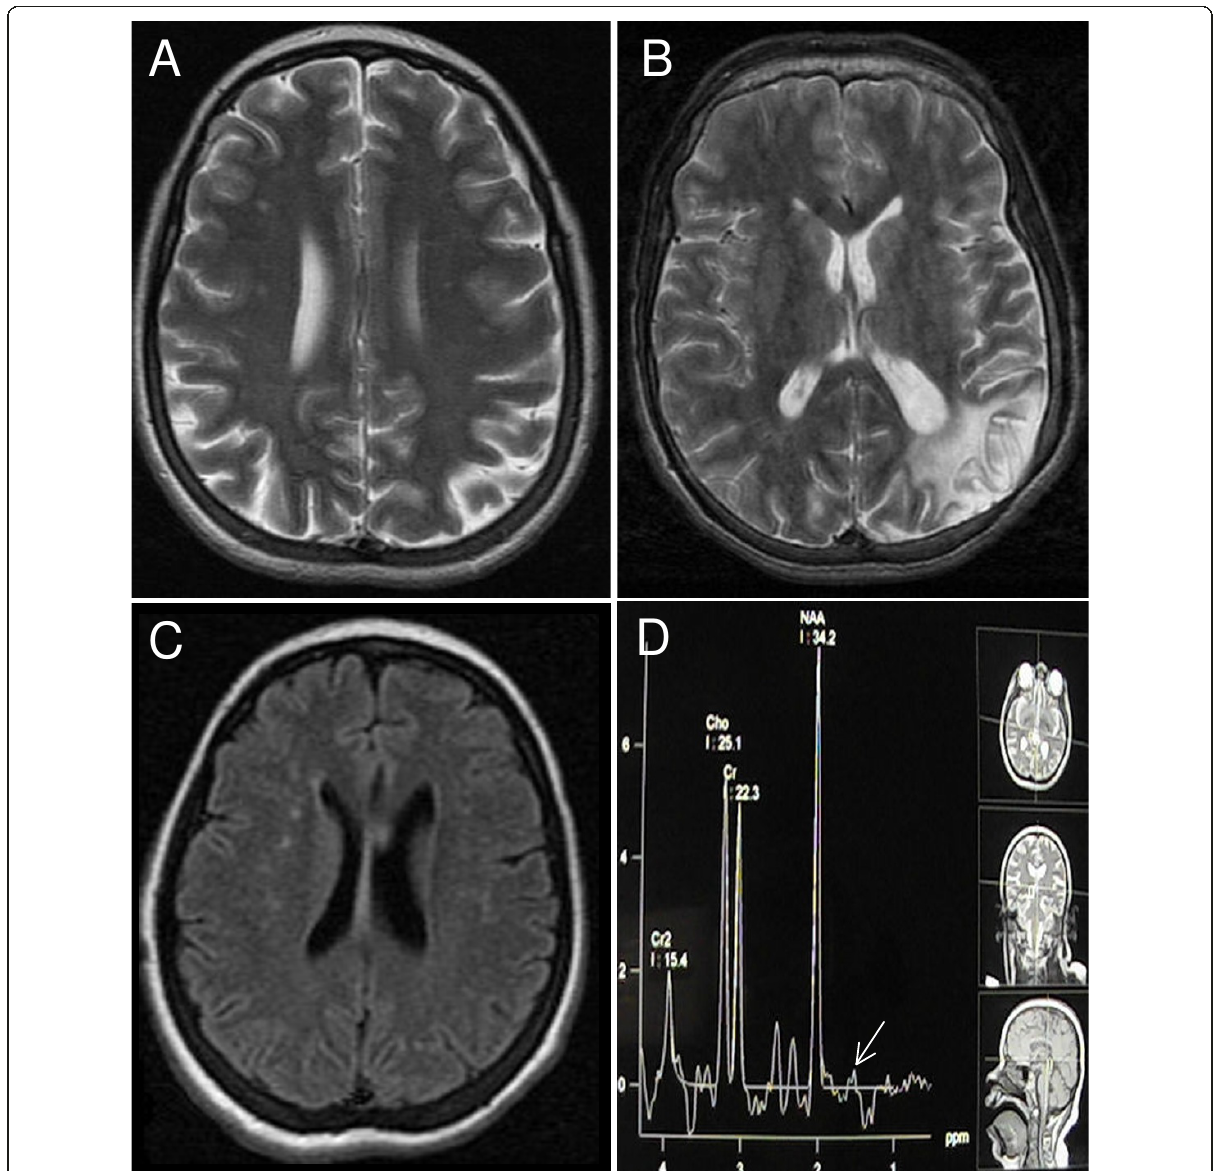
Figure 2 MRI and MR spectroscopy of RBT-DAK patients . Axial T2-weighted images of patients V.1 (A) and V.4 (B), FLAIR image of patient V.2 (C) and MR spectroscopy of patient V.2 (D) showing a small peak of lactate (see